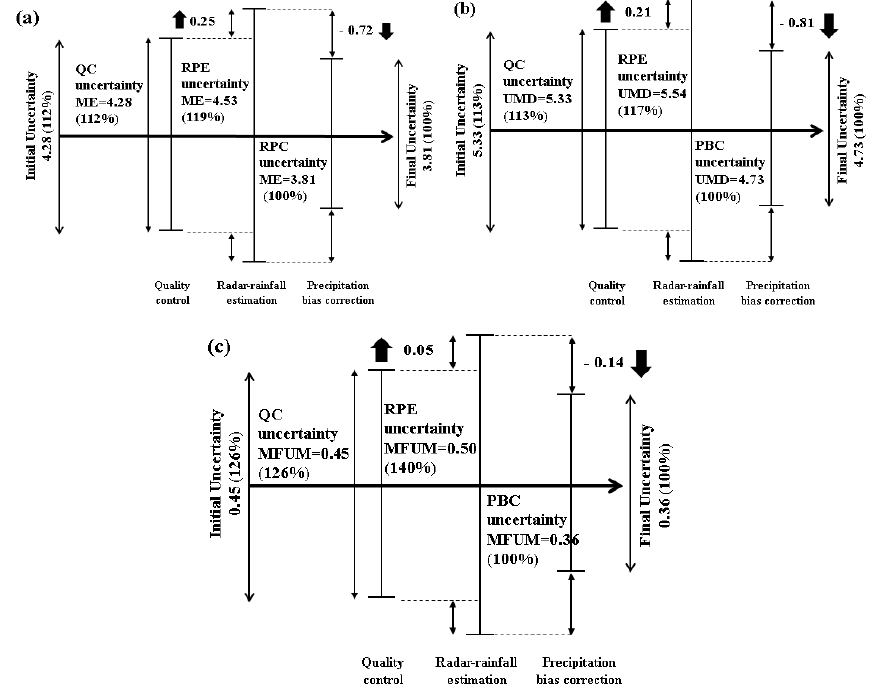
Figure 5. Uncertainty quantification and propagation in the radar-based precipitation estimation Figure 5 . Uncertainty quantification and propagation in the radar ‐ based precipitation estimation process using ( a ) the MEM, ( b ) the UDM, and ( c ) the